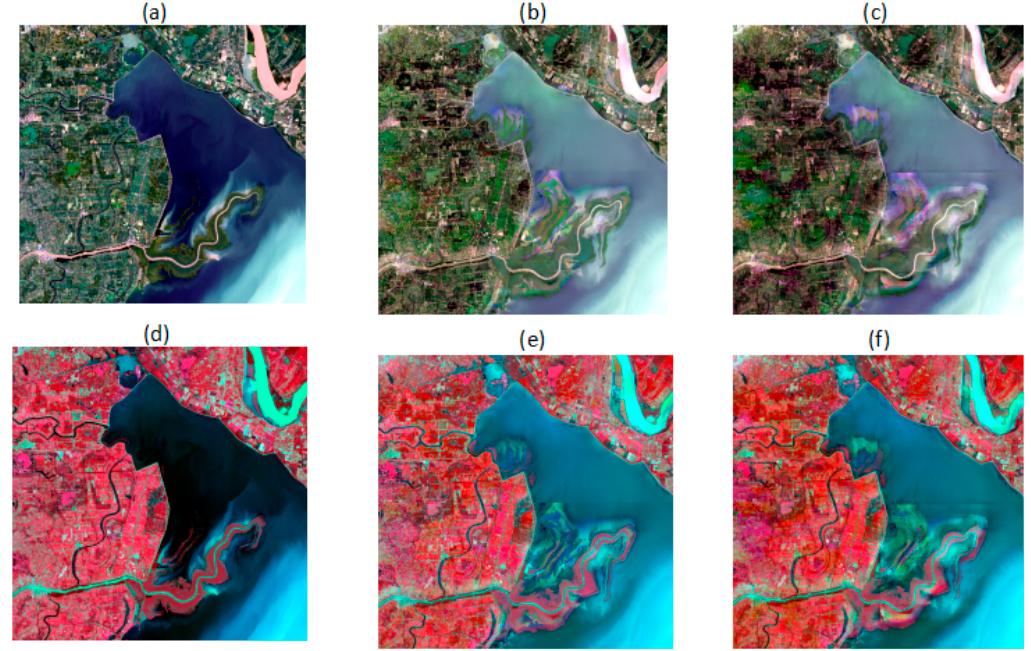
Figure 6. ( a , d ) Actual images observed on 23 July 2016; ( b , e ) Prediction images by ESTARFM; ( c , f ) Prediction images by the modified algorithm using phenological information. The upper rows are red-green-blue composites of Landsat surface reflectance and the lower rows are NIR-red-green composites of Landsat surface reflectance. Table 2. Regression coefficient of the linear fitting equation, correlation coefficient, and root mean square error for 19 July 2016, and predicted reflectance compared with real reflectance on 23 July 2016, for paddy rice. ESTARFM The Modified Algorithm Using Phenological Information